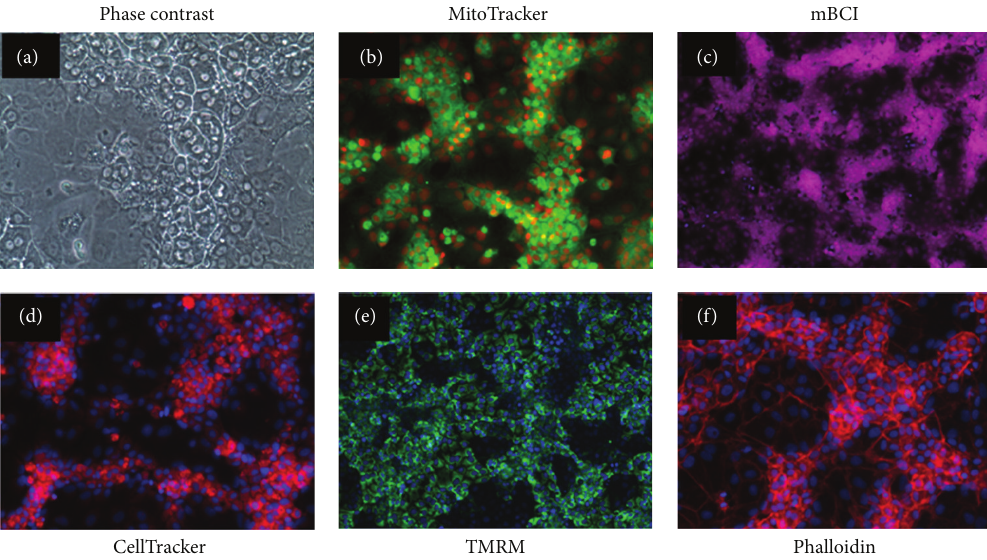
Figure 9: Labeling of HepaRG with cell function and structure dyes. Images shown represent HepaRG cells plated on 96-well collagen coated plates in growth media at 50,000 cells per well and cultured for 3 days. Images shown represent label-free phase contrast imaging of live cells (a); live cells stained with MitoTracker Green FM (b); live cells stained with Monochlorobimane (mBCI) (c); live cells stained with CellTracker Red CMTPX (d); live cells stained with Tetramethylrhodamine, Methyl Ester, and Perchlorate (TMRM) (e); and fixed cells stained with Alexa Fluor 568 Phalloidin